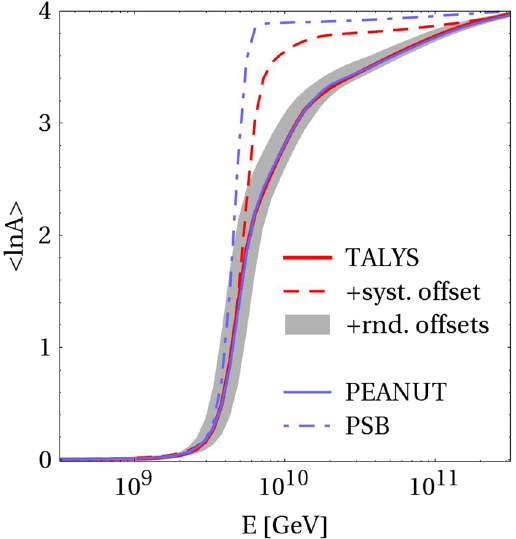
Figure 4. Emitted cosmic ray composition from a GRB as a function of observed energy without propagation effects for various nuclear disintegration models (same parameters as in Fig. 3, iron injection only; see main text for details of the models). Here it is assumed that cosmic ray nuclei either escape as neutrons from the source (which leads to escape spectra ∝ E − 2 ), or as charged particles if they can reach the outside of the source within their Larmor radius (“direct escape”, which leads to harder escape spectra ∝ E − 1 , see ref. 38), that is consistent with what found in ref.